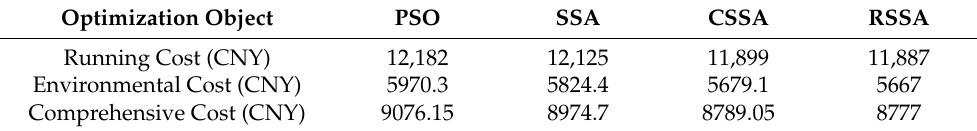
Table 10. Comparison of optimization results of different algorithms in a typical day in summer. Optimization Object